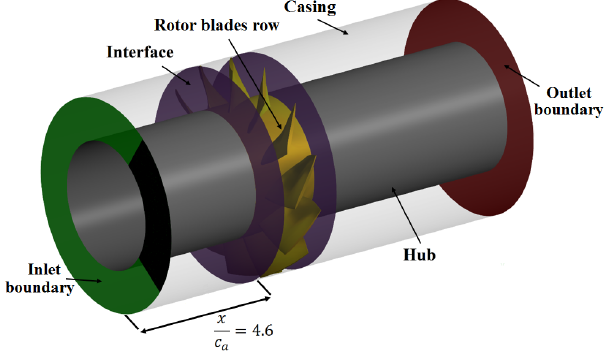
Figure 5. Boundary conditions of solution